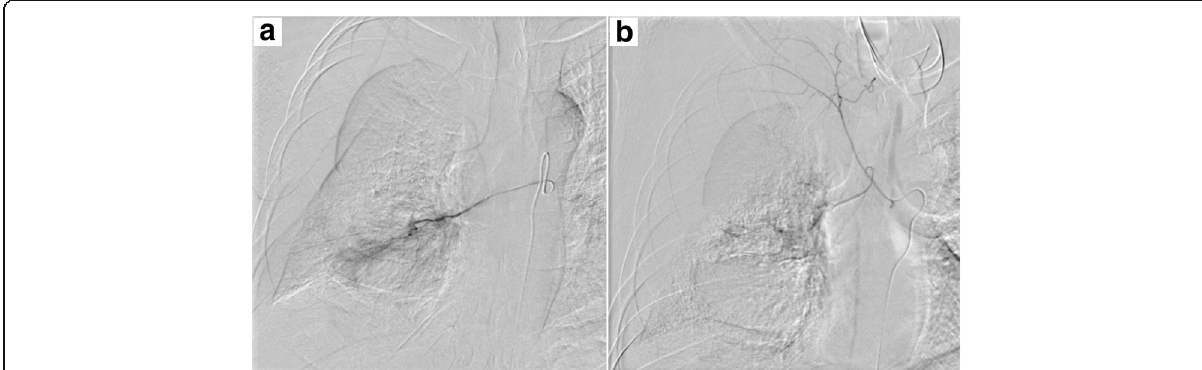
Fig. 3 Findings of angiography of the bronchial artery. The descending aorta, and the superior and inferior branches of the right bronchial arteries were selectively imaged. The inferior branch of the bronchial artery ( a ) and another branch from the superior branch of the right bronchial artery ( b ) were thought to supply blood to the tumor and were embolized